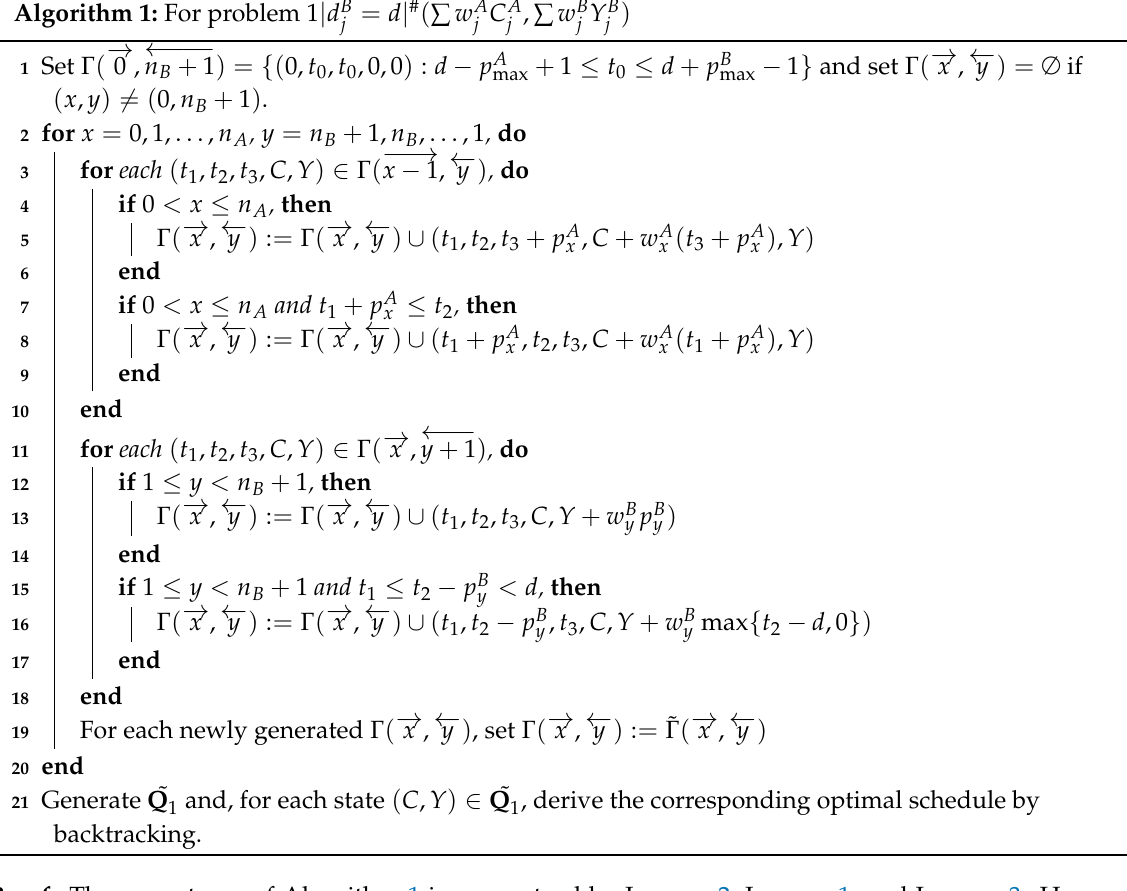
Algorithm 1: For problem 1 | d B